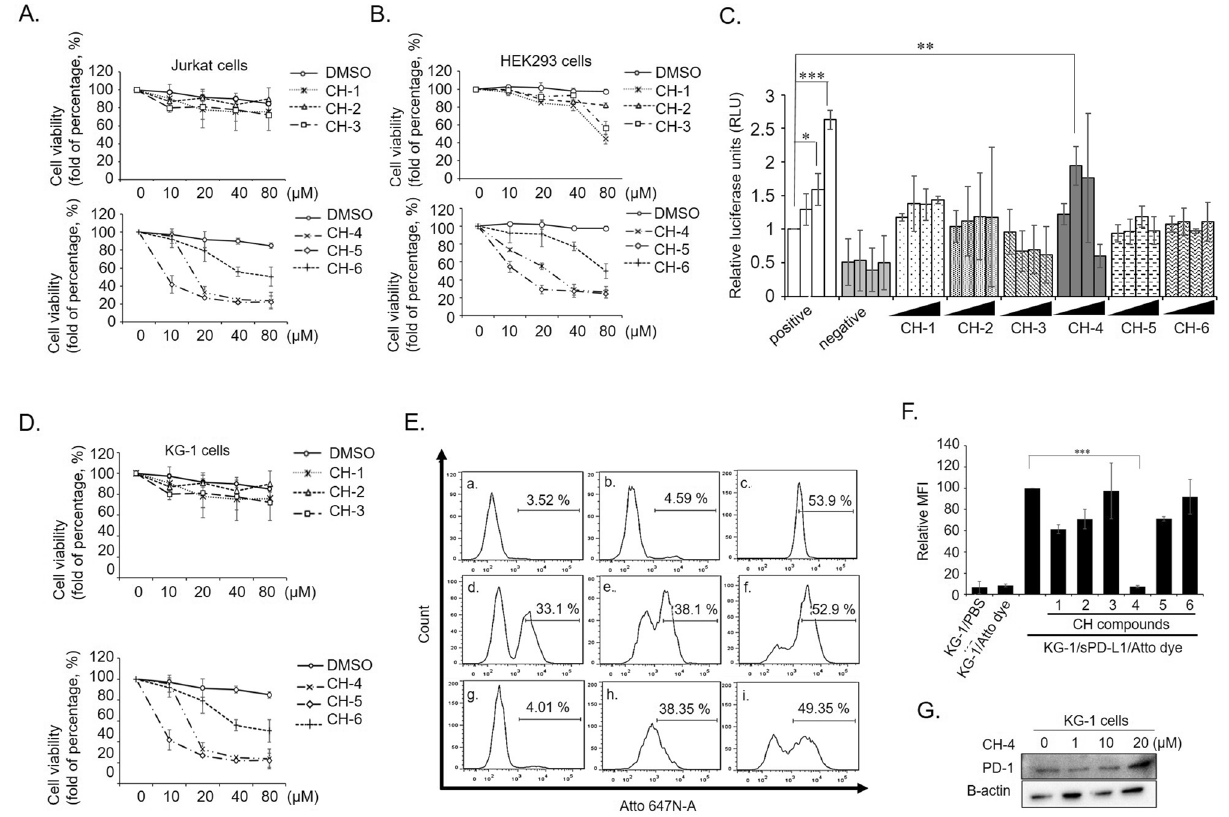
Figure 2. In vitro screening of leading compounds. ( A ) Jurkat cells and ( B ) HEK293 cells were treated with six leading compounds to test cytotoxicity. Cells were seeded into 96-well plates at a density of 7 × 10 3 /well and incubated overnight. The cells were then treated for 48 h with different concentrations (0, 10, 20, 40, and 80 µM) of the six CH compounds. At 48 h, cell cytotoxicity WST-1 assays were performed. The x-axis indicates treatment concentrations, while the y-axis indicates the percentage of cell viability (each absolute absorbance value [abs. 450 nm–630 nm] was normalized with the controls). ( C ) The capacity of the CH compounds to inhibit the PD-1/PD-L1 interaction was tested using the bioluminescent cell-based assay. Effector cells (growth- arrested reporter Jurkat cells) were preincubated with anti-PD-1 neutralizing antibody (Cat No. 71120), DMSO, or each of the CH compounds. The activity of luciferase was determined as an indicator of cell activation. The graphs present mean ± SD (standard deviation) values from at least three independent experiments. ( D ) After overnight incubation, KG-1 cells were treated for 48 h with increasing concentrations of the CH compounds (0, 10, 20, 40, or 80 µM). ( E ) KG-1 cells were incubated with CH compounds prior to sPD-L1-Atto staining. Flow cytometry determined binding of the Ni–NTA-labeled sPD-L1 (PD-L1-Atto) complex to KG-1 cells expressing PD-1. Cell staining (Atto-subset) was blocked in the presence of the CH compounds. The experimental groups are indicated as (a) KG-1/PBS, (b) KG-1/Atto dye, (c) KG-1/sPD-L1/Atto dye, (d) KG-1/sPD-L1/Atto dye/CH-1, (e) KG-1/sPD-L1/Atto dye/CH-2, (f) KG-1/sPD-L1/Atto dye/CH-3, (g) KG-1/sPD-L1/Atto dye/ CH-4, (h) KG-1/sPD-L1/Atto dye/CH-5, (i) KG-1/sPD-L1/Atto dye/CH6. ( F ) The cell staining data from ( E ) are normalized and quantified as relative MFI values. ( G ) At 48 h, PD-1 protein (20 µg/well) expression was determined by Western blotting. The bar graphs present the mean ± SD (standard deviation) values from three independent experiments. * p < 0.05, ** p < 0.01, *** p < 0.001.